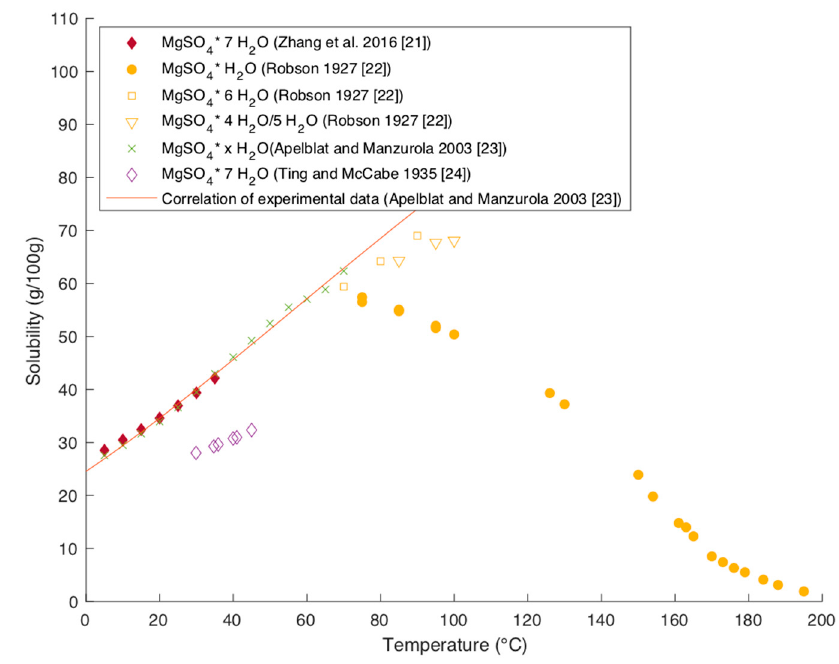
Figure 9. Solubility of MgSO 4 in water [21–24].